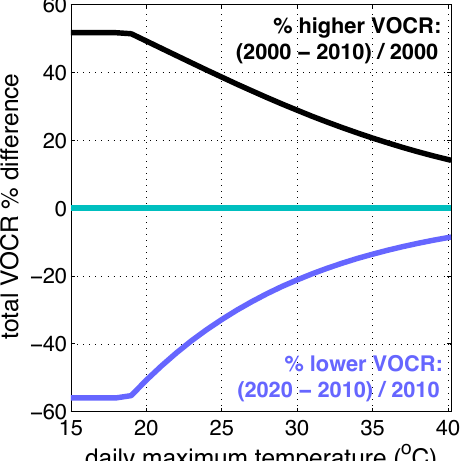
Fig. 3. The effects of organic emission reductions on the total VOCR versus daily maximum temperature ( ◦ C). We assume here that the temperature-independent 6 i VOCR i of 2.1s − 1 has de- creased and will continue to decrease at a rate of 6%yr − 1 and that the temperature-dependent reactivity has been and will continue to be unchanged. The percent difference (higher) in the total VOCR in 2000, (VOCR 2000 – VOCR 2010 )/VOCR 2000 , is in black. The percent change (lower) in the total VOCR in 2020, (VOCR 2020 – VOCR 2010 )/VOCR 2010 , is in periwinkle. The turquoise line is the year 2010 at